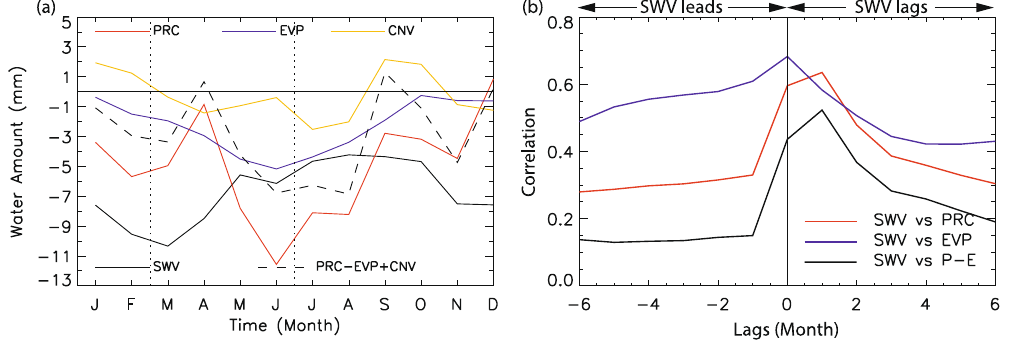
Figure 3. ( a ) The annual variation of various hydrological factors due to NH warming over the target domain [240°–270°E × 30°–45°N]. ( b ) Lagged correlation between soil water volume and precipitation and evaporation after removing the annual